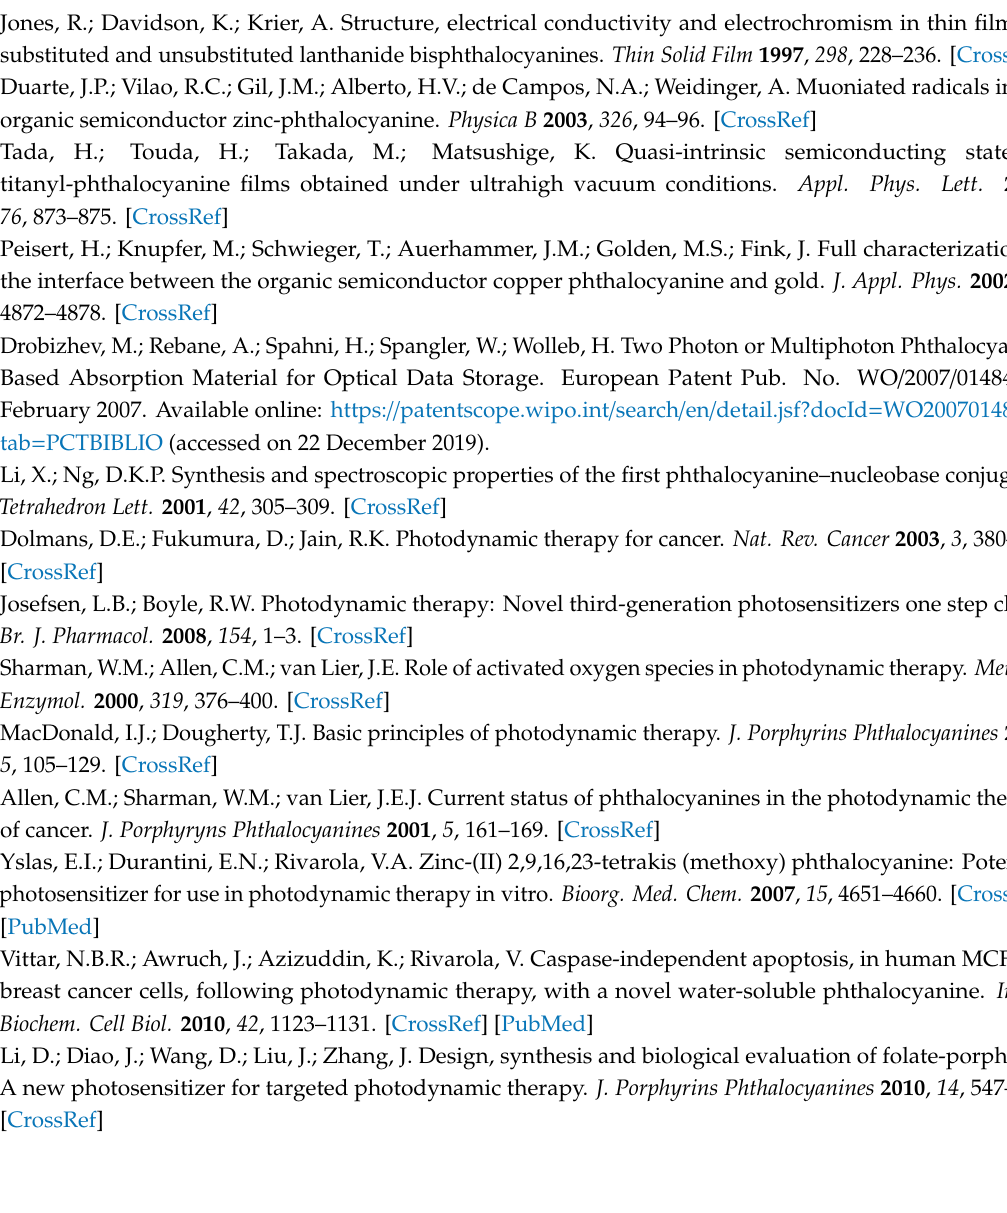
Figure S1: TEM and SEM images of graphite oxide flakes with zirconium(IV) phthalocyanine derivatives; Figure S2: Mass spectra of ( a ) bis (PABA) ZrPc, ( b ) bis (DAPA) ZrPc; Table S1: IR wavenumbers and relative intensities of observed bands together with proposed assignment for the studied complexes and